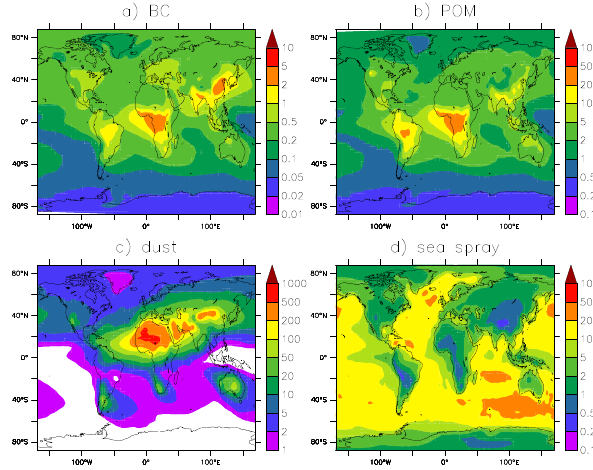
Fig. 5. Seasonal cycle of aerosol number concentration (cm − 3 ) in four locations as measured by the Global Atmopsheric Watch network. Lines show modelled values for 2001 (black) and 2002 (blue) and observed values for 2001 (red dash) and 2002 (green dash).